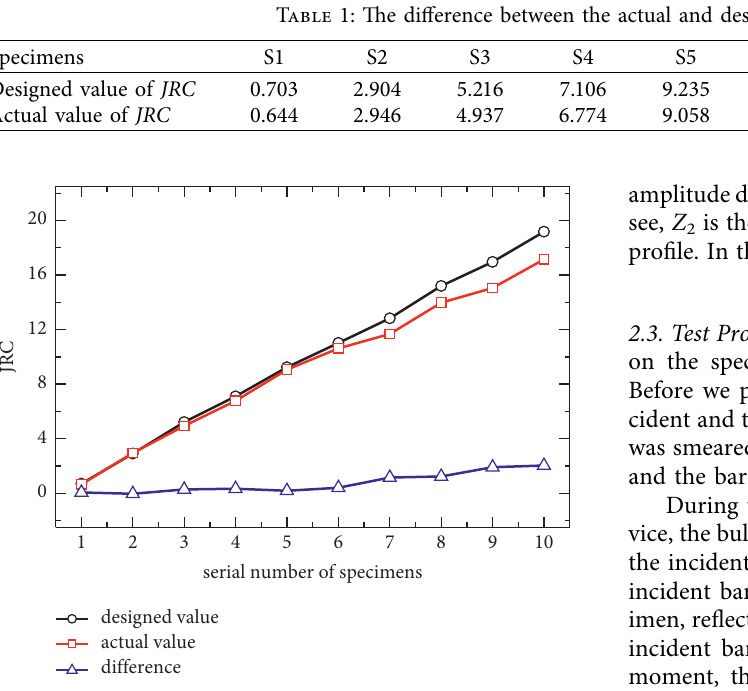
Figure 4: The difference between the actual and designed values of